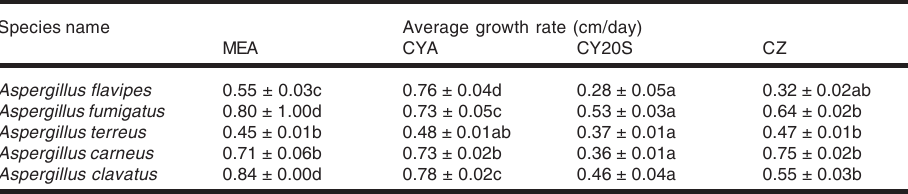
Table 1. Average growth rate of Aspergillus species on different